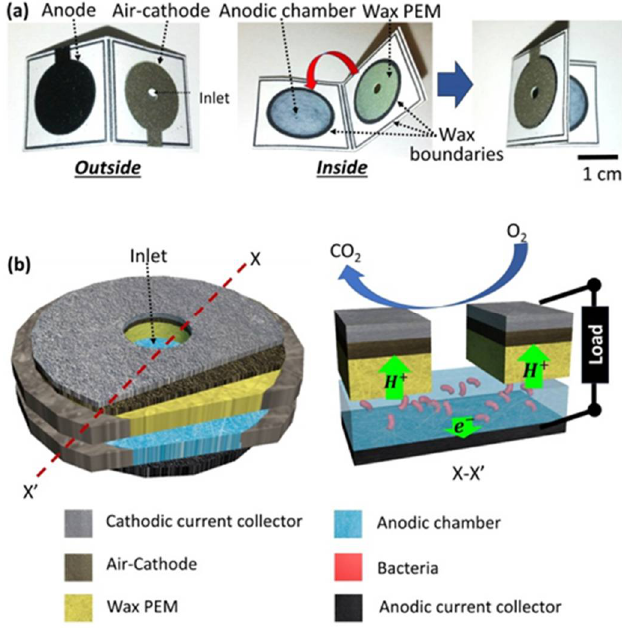
Figure 6. ( a ) Photos and ( b ) schematics of the single microbial fuel cell (MFC) unit.